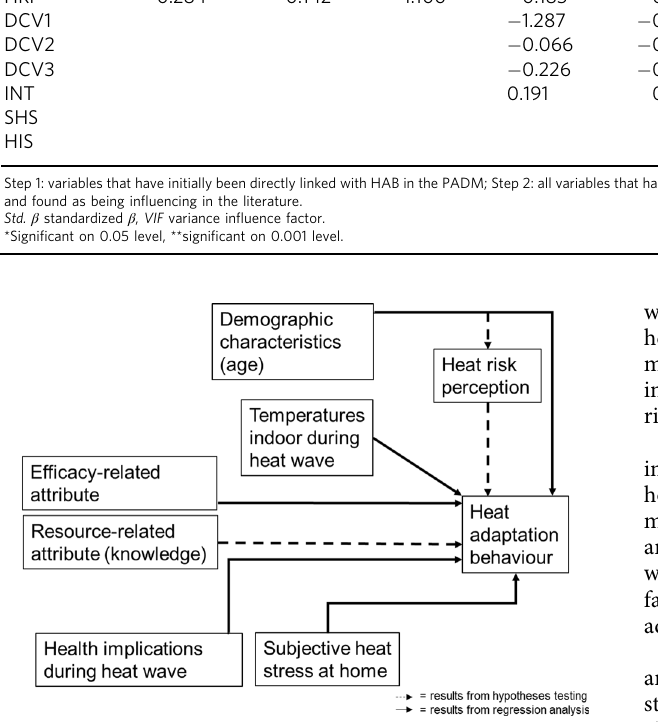
Fig. 2 Adjusted PADM for heat adaptation behaviour in this study. Figure shows fl ow of inormation in the adjusted PADM for this study. Boxes show variables, arrows show results from regression analysis and dotted arrows show results from hypotheses